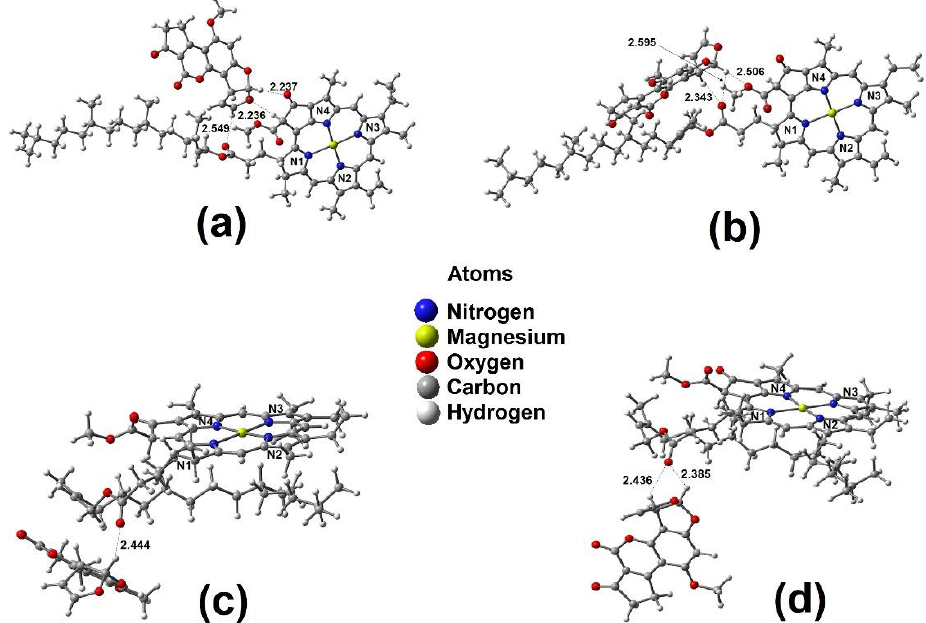
Figure 4. Optimized geometry of ( a ) chl a 1 – AFB 1 a (three hydrogen bond interactions), ( b ) chl a 1 – AFB 1 b (three hydrogen bond interactions); ( c ) chl a 2 – AFB 1 c (one hydrogen bond interaction), and ( d ) chl a 2 – AFB 1 d (two hydrogen bond interactions).